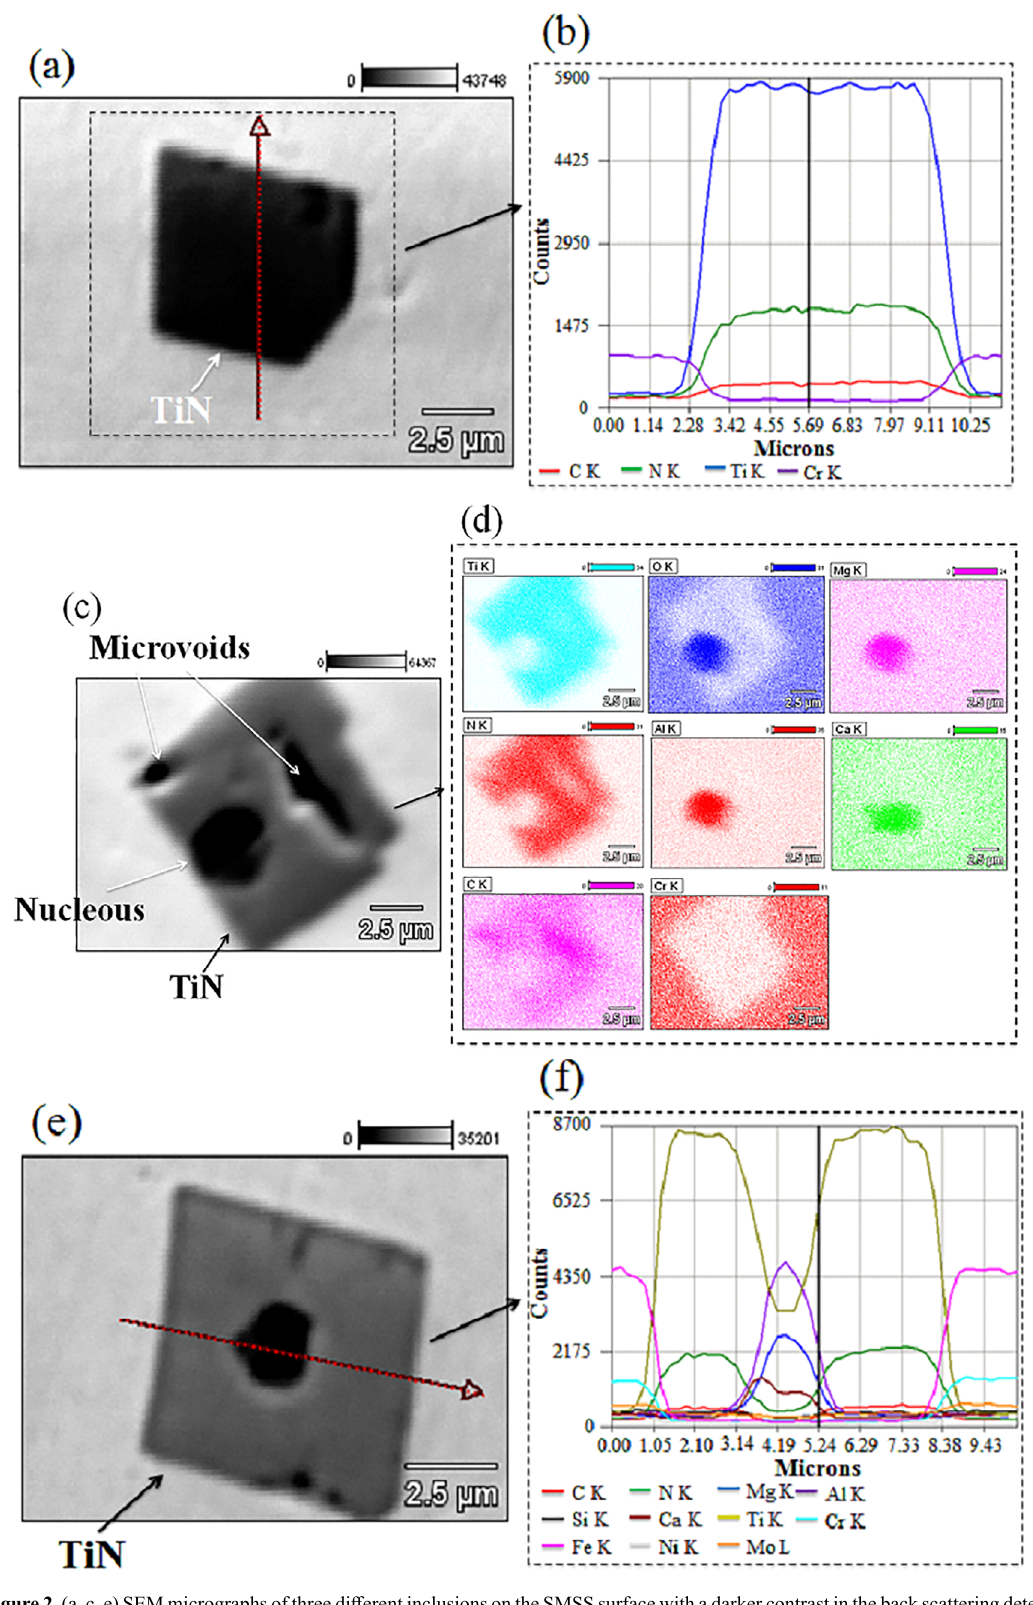
Figure 2. (a, c, e) SEM micrographs of three different inclusions on the SMSS surface with a darker contrast in the back scattering detector of SEM, which could be identified as TiN by EDS analysis (b, d,